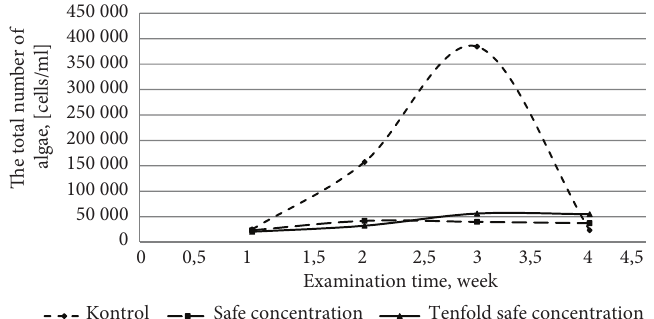
Figure 2. Dynamics of total number of algae development in microcosm